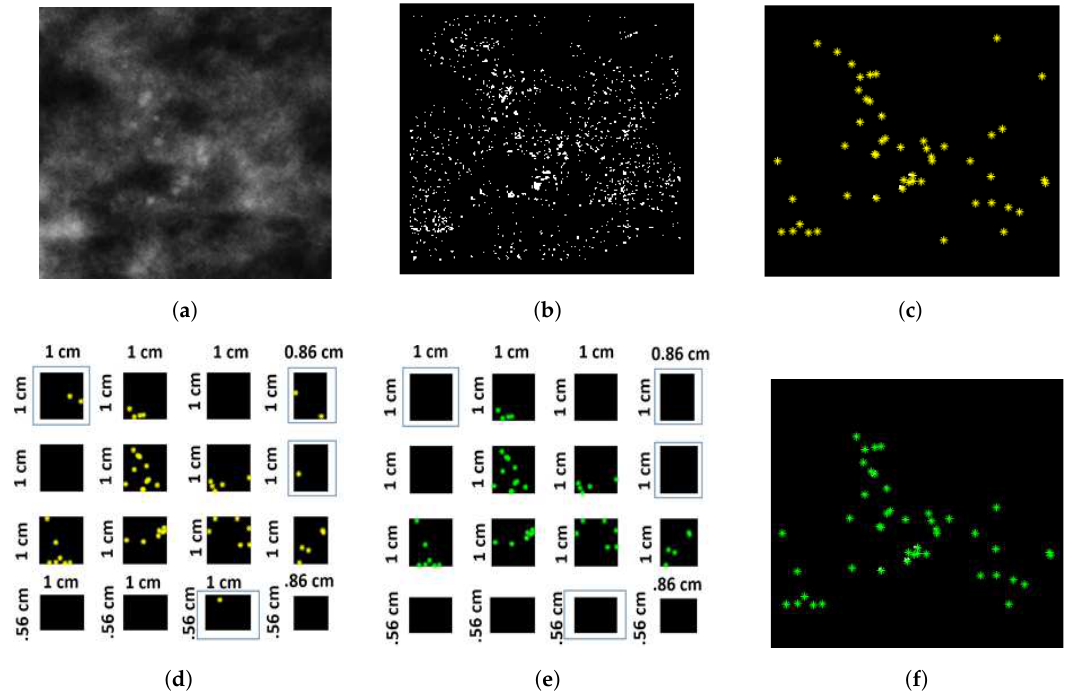
Figure 7. ( a ) Enhanced image patch ( 10_35_242 ) from the OMI-DB database; ( b ) Image C: logical summation of two binary Images A and B for image patch ( 10_35_242 ); ( c ) eliminating single pixel from ( b ) (all MCs are highlighted for better visual understanding); ( d ) dividing ( c ) into 1 cm 2 pixel blocks: the blocks containing fewer than three MCs are marked by a rectangle, the last row and the last column of image blocks were not 1 cm 2 pixel block as they were adjusted according to the patch image size; ( e ) elimination of all MCs inside each 1 cm 2 pixel block that contained fewer than three MCs (marked by a rectangle); and ( f ) all blocks in ( e ) are stitched together to produce the final segmented